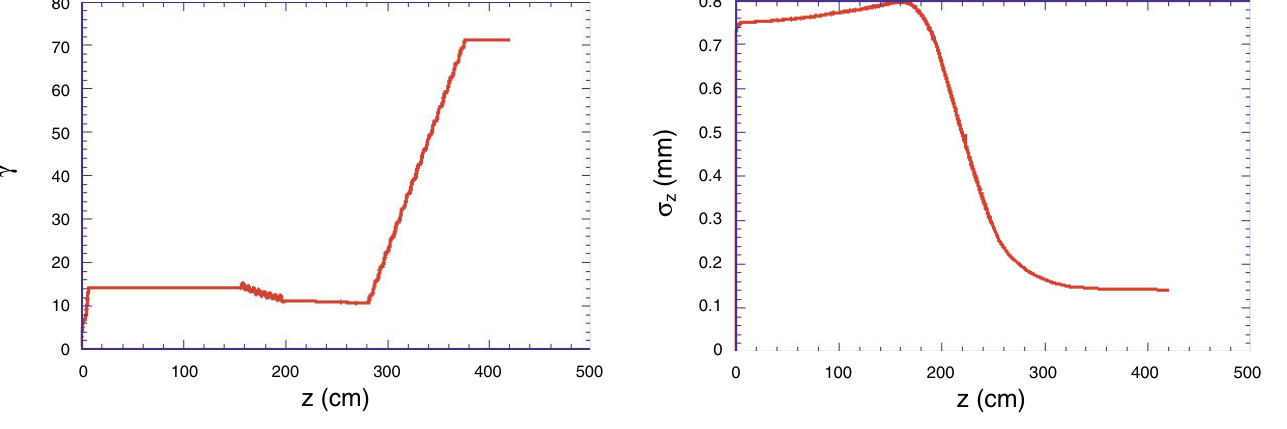
FIG. 2. (Color) The evolution of the normalized beam energy for 1 nC beam in the ORION photoinjector, velocity-bunching case, from PARMELA simulation.